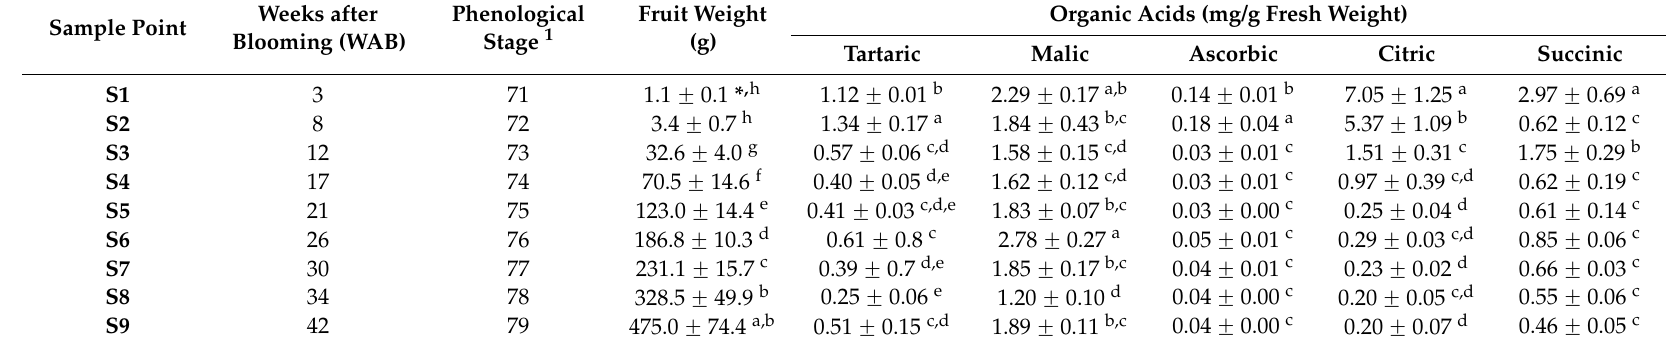
Table 1. Organic acid contents of cherimoya fruit at nine stages of development, collected during 42 weeks. Results are expressed as the mean ˘ standard error (SE) of four separate extractions and determinations.